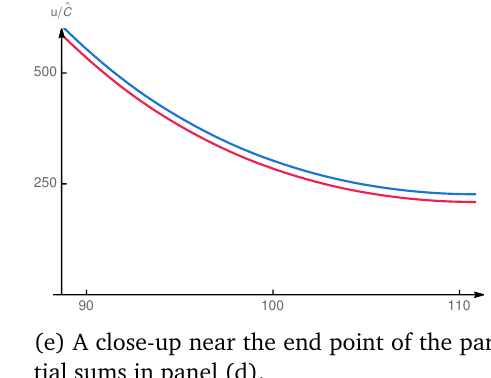
(blue) to (5.15) is indistinguishable from the sum of the first ten eigenfunctions (red). Figure 4: An instance of the Schrödinger problem (5.42) with ˆ (cid:96) ∼ 221, ˆ y / v ∼ 2 × 10 15 . In panel 4a we see the slowly-varying Casimir circle ˆ R N 7 7 smoothly-shrinking circle ˆ R . Comparing with 4b, we see that when ˆ R contribution to the potential gives rise to a finite potential barrier. The total potential has a slightly negative region, compatible with the bounds in the main text. In panel 4c we show the first eigenstates. From panels 4d, 4e we see that the ground state is a very good approximation to u , and from the close-up in panel 4e we can check that u stays finite on the smooth